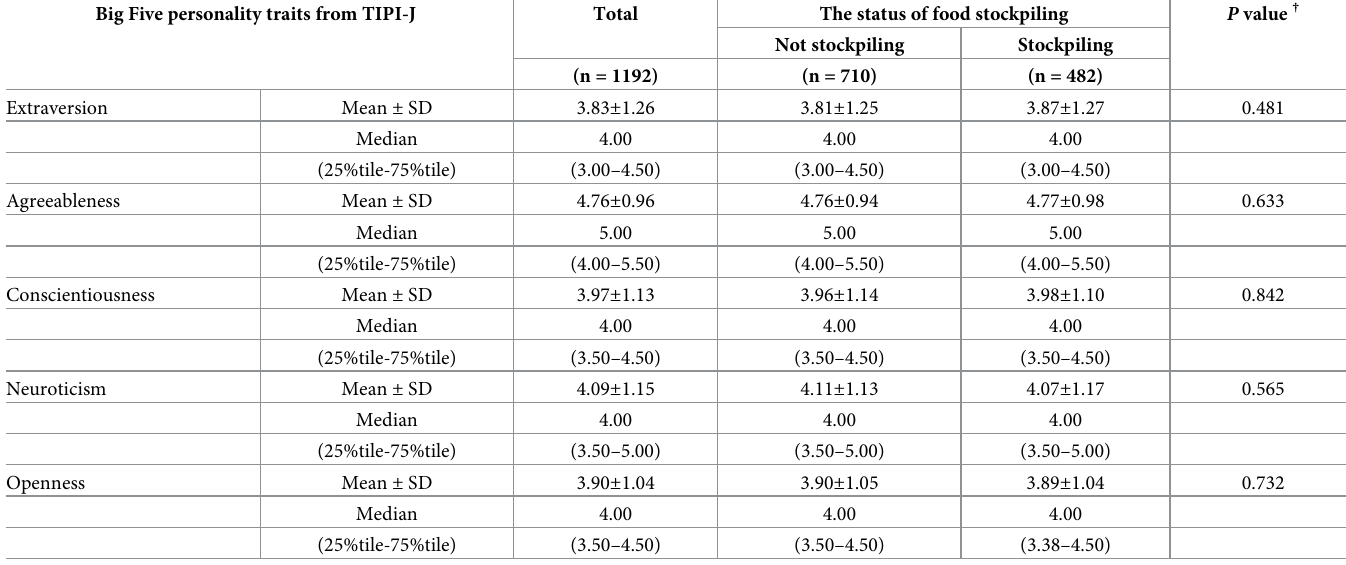
Table 2. The distribution of Big-Five personality by the status of stockpiling disaster food. Big Five personality traits from TIPI-J